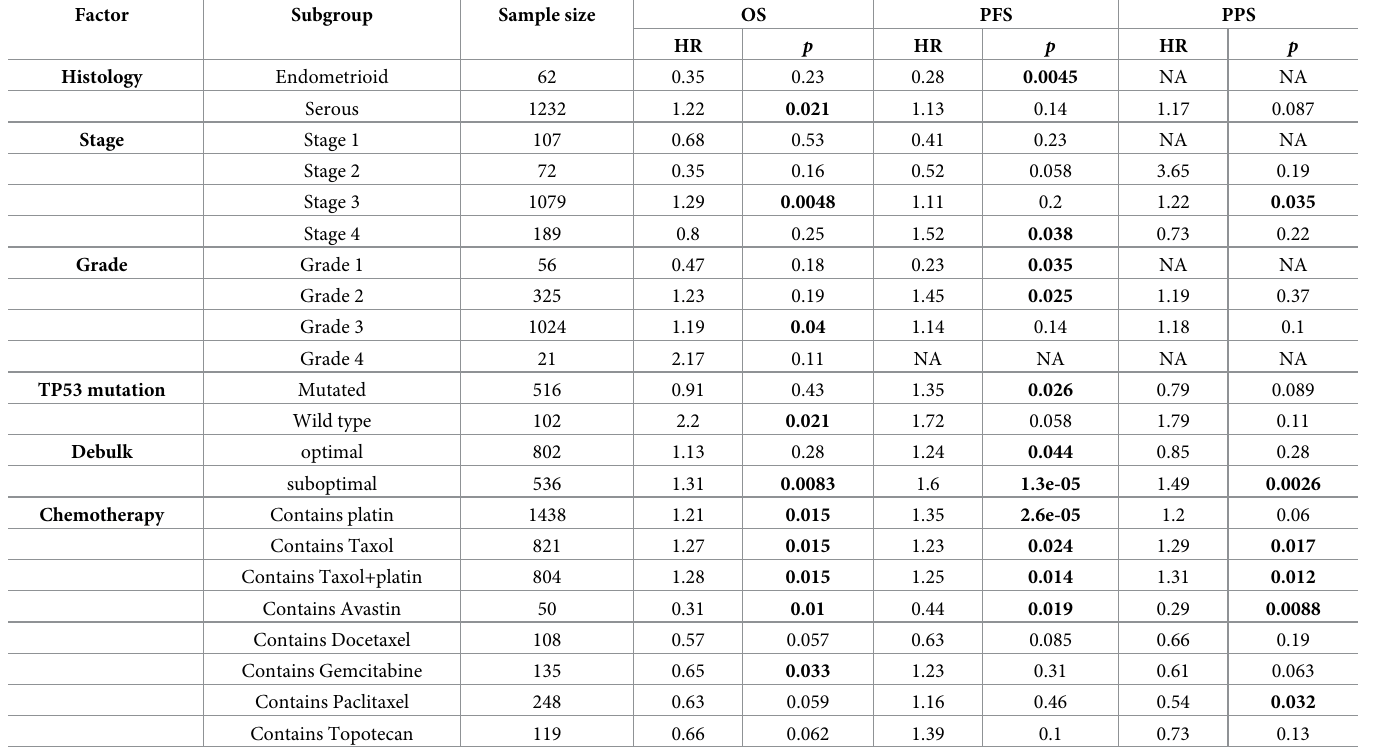
Table 2. Subgroup analysis on the correlation of SMARCA1 expression and prognosis of ovarian cancer